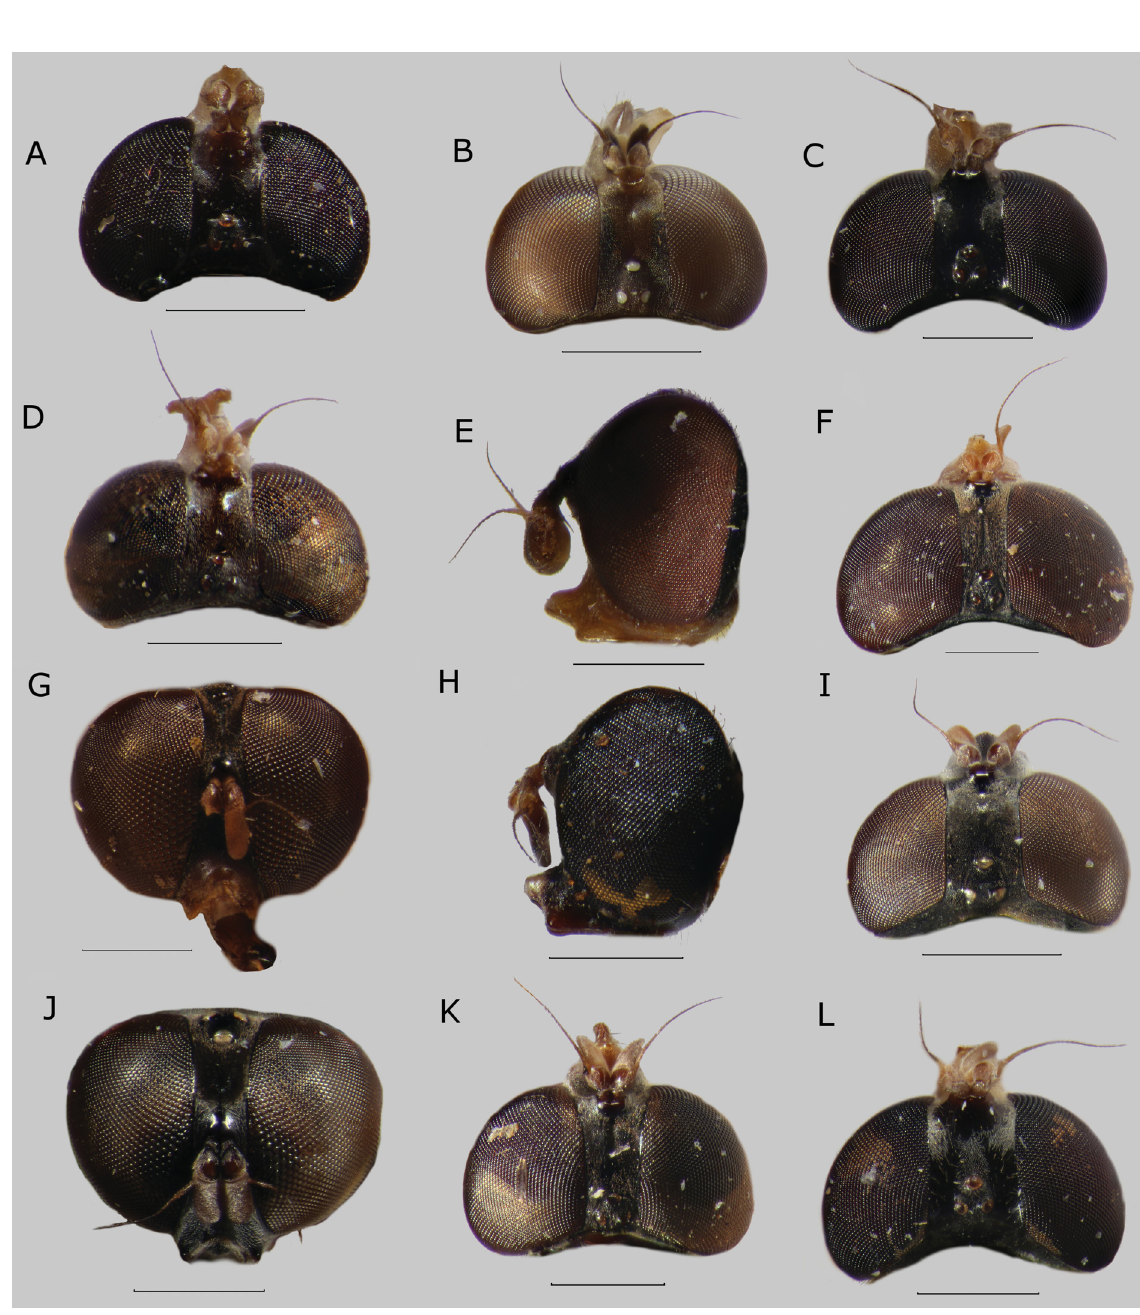
Fig. 84. Head, lateral view (E, H), dorsal view (A–D, F, I, K–L) and frontal view (G, J). A . Sphe gina (Asiosphegina) nasuta Hippa, van Steenis & Mutin, 2015, paratype, ♂ , Myanmar. B . S. (A.)